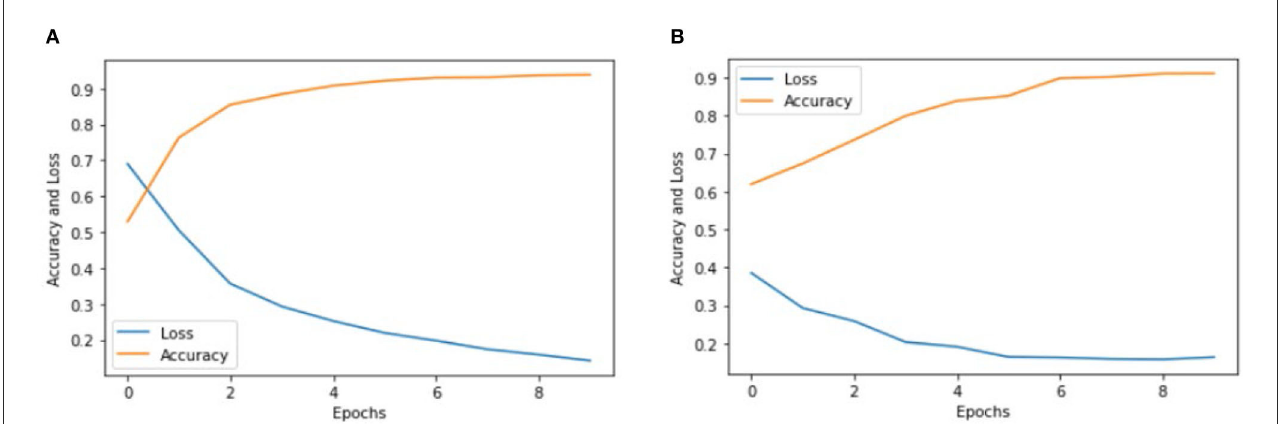
FIGURE5 Accuracy and loss graph using the Inception V3 and VGG-16. (A) Representing the training accuracy and loss by using Inception V3 and (B) representing the training accuracy and loss of the VGG-16 models according to our dataset.